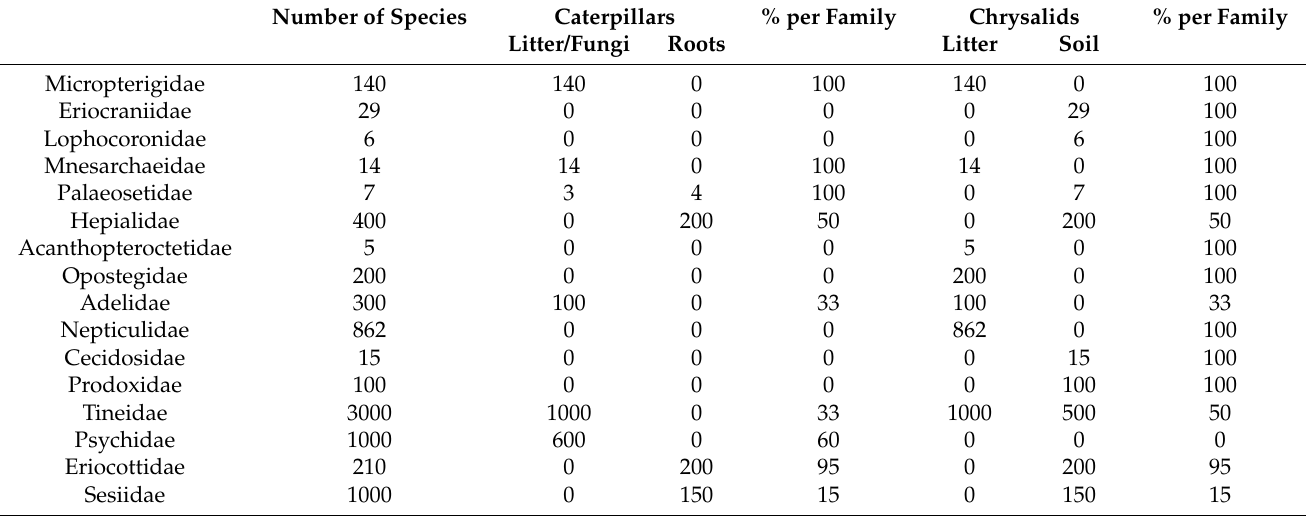
Table 1. Rough estimates of the number of soil-related Lepidoptera species. For each subdivision used in this work, an estimate of the number of currently described species (i.e., based on 157,000 species) was made and only those subdivisions where at least one species has a relationship with soil are included (i.e., a total of 64,484 species = 41% of the total species). In each of the subdivisions where there is at least one soil-related species, an estimate of the number of species related to the soil is given. The results are presented separately for caterpillars and chrysalises. For caterpillars, those that feed on litter and fungi have been separated from those that feed on roots. Similarly, for chrysalises, a separation was made between species that nymph in the litter and those in the soil. Column 2: Number of species for each family with at least one species described to be related to soil. Column 3–5: Number of species feeding on litter or fungi and those feeding on roots + overall percentage per family of soil-using caterpillars. Column 6–8: Number of species nymphalizing in litter or soil + overall percentage by family of species pupating in the soil.